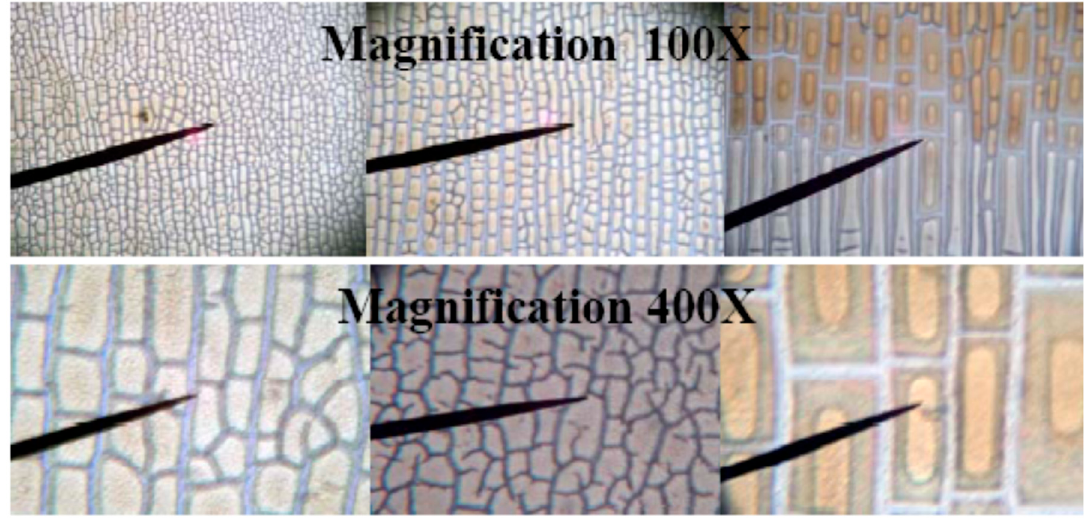
Figure 9. Optical micrographs of thin films of P-1 on glass substrates.